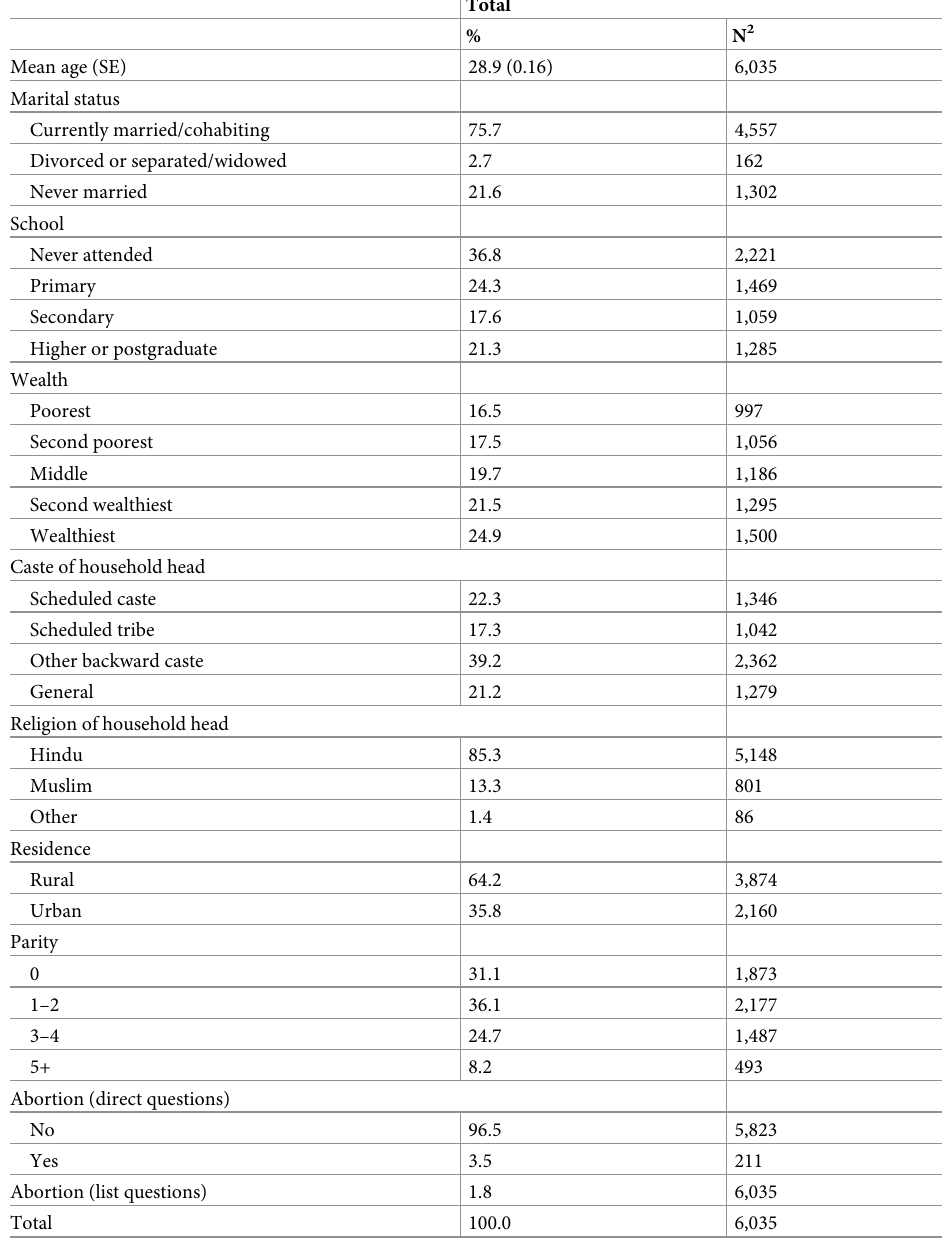
Table 2. Socioeconomic characteristics of Rajasthani women age 15 to 49 1